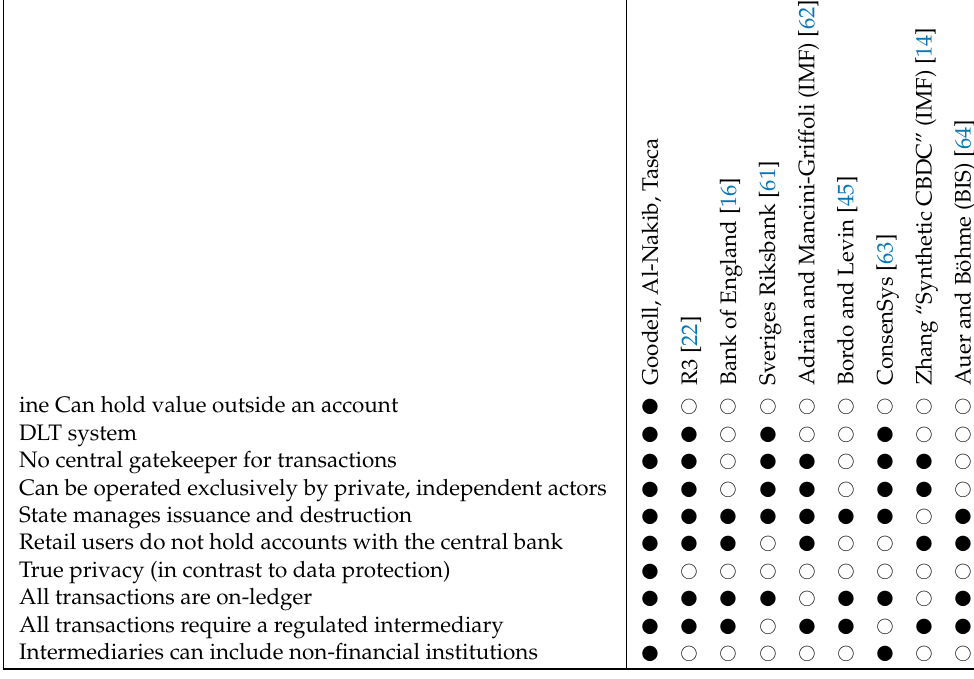
Table 1. Comparison of features among proposed retail digital currency